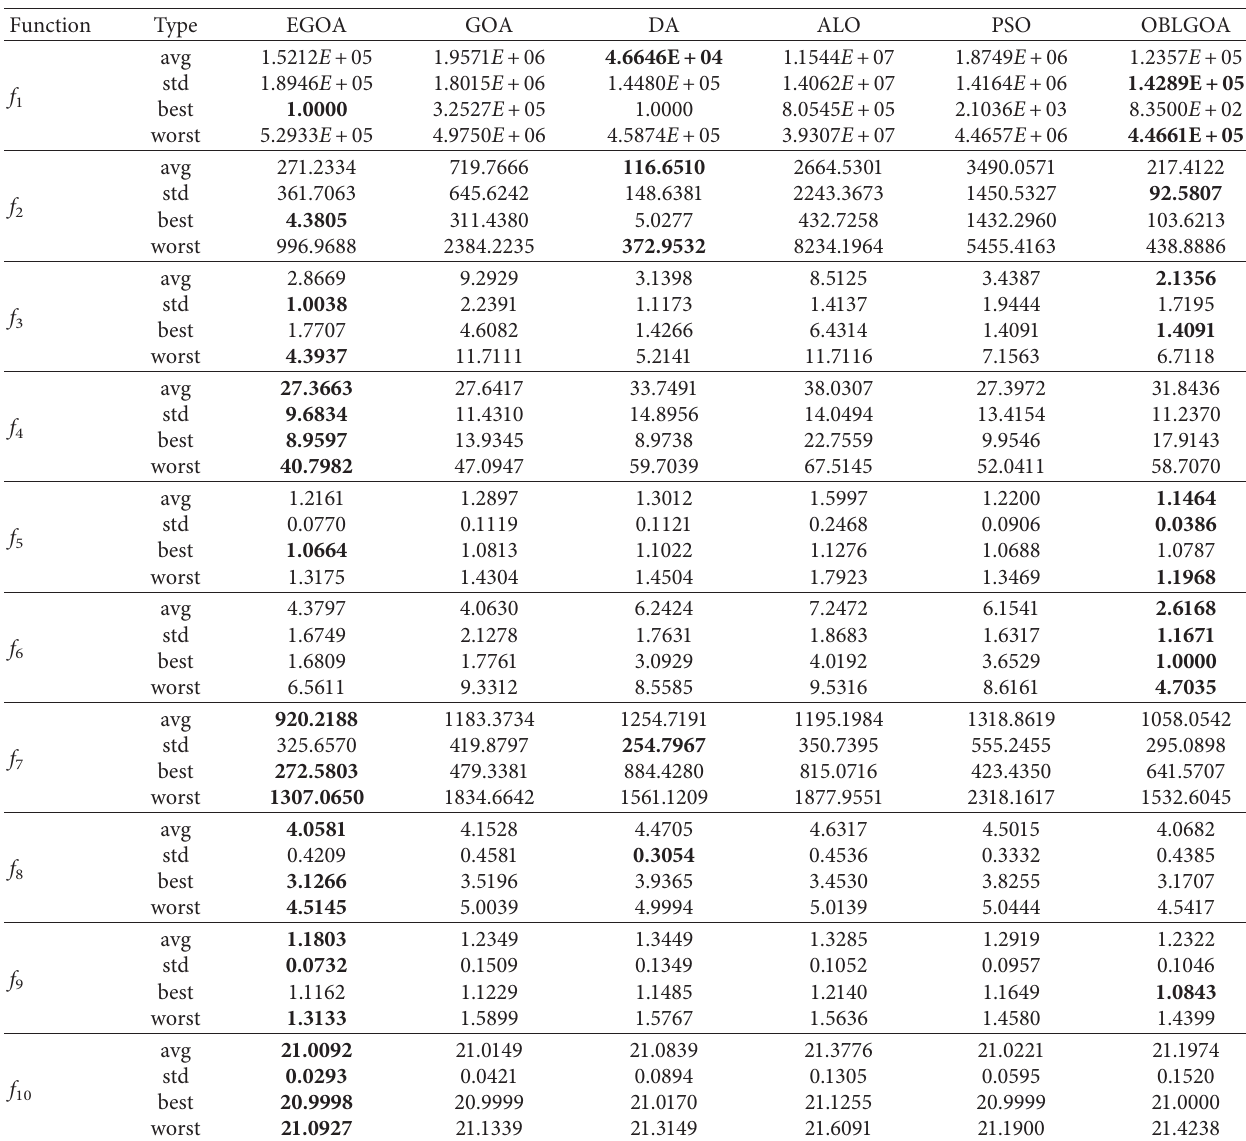
Table 9: Results for CEC2019